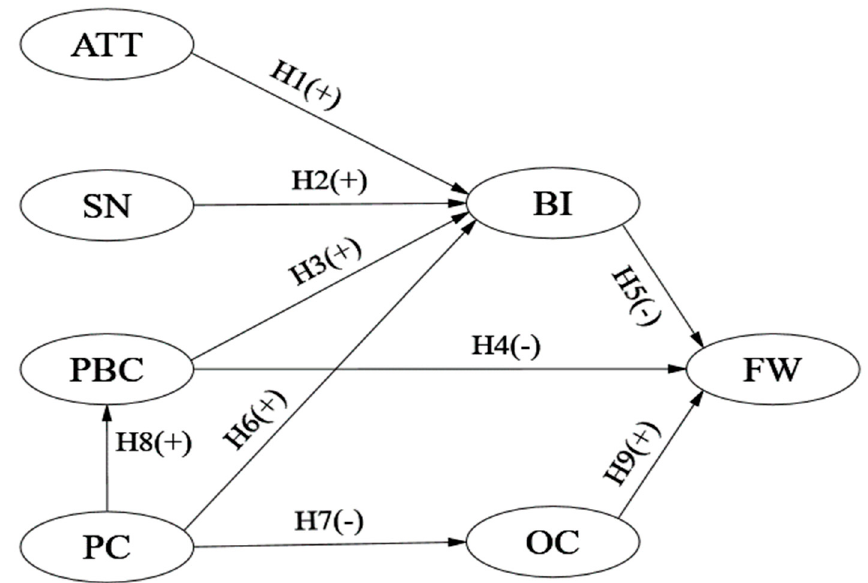
Figure 2. Theoretical hypothesis model.